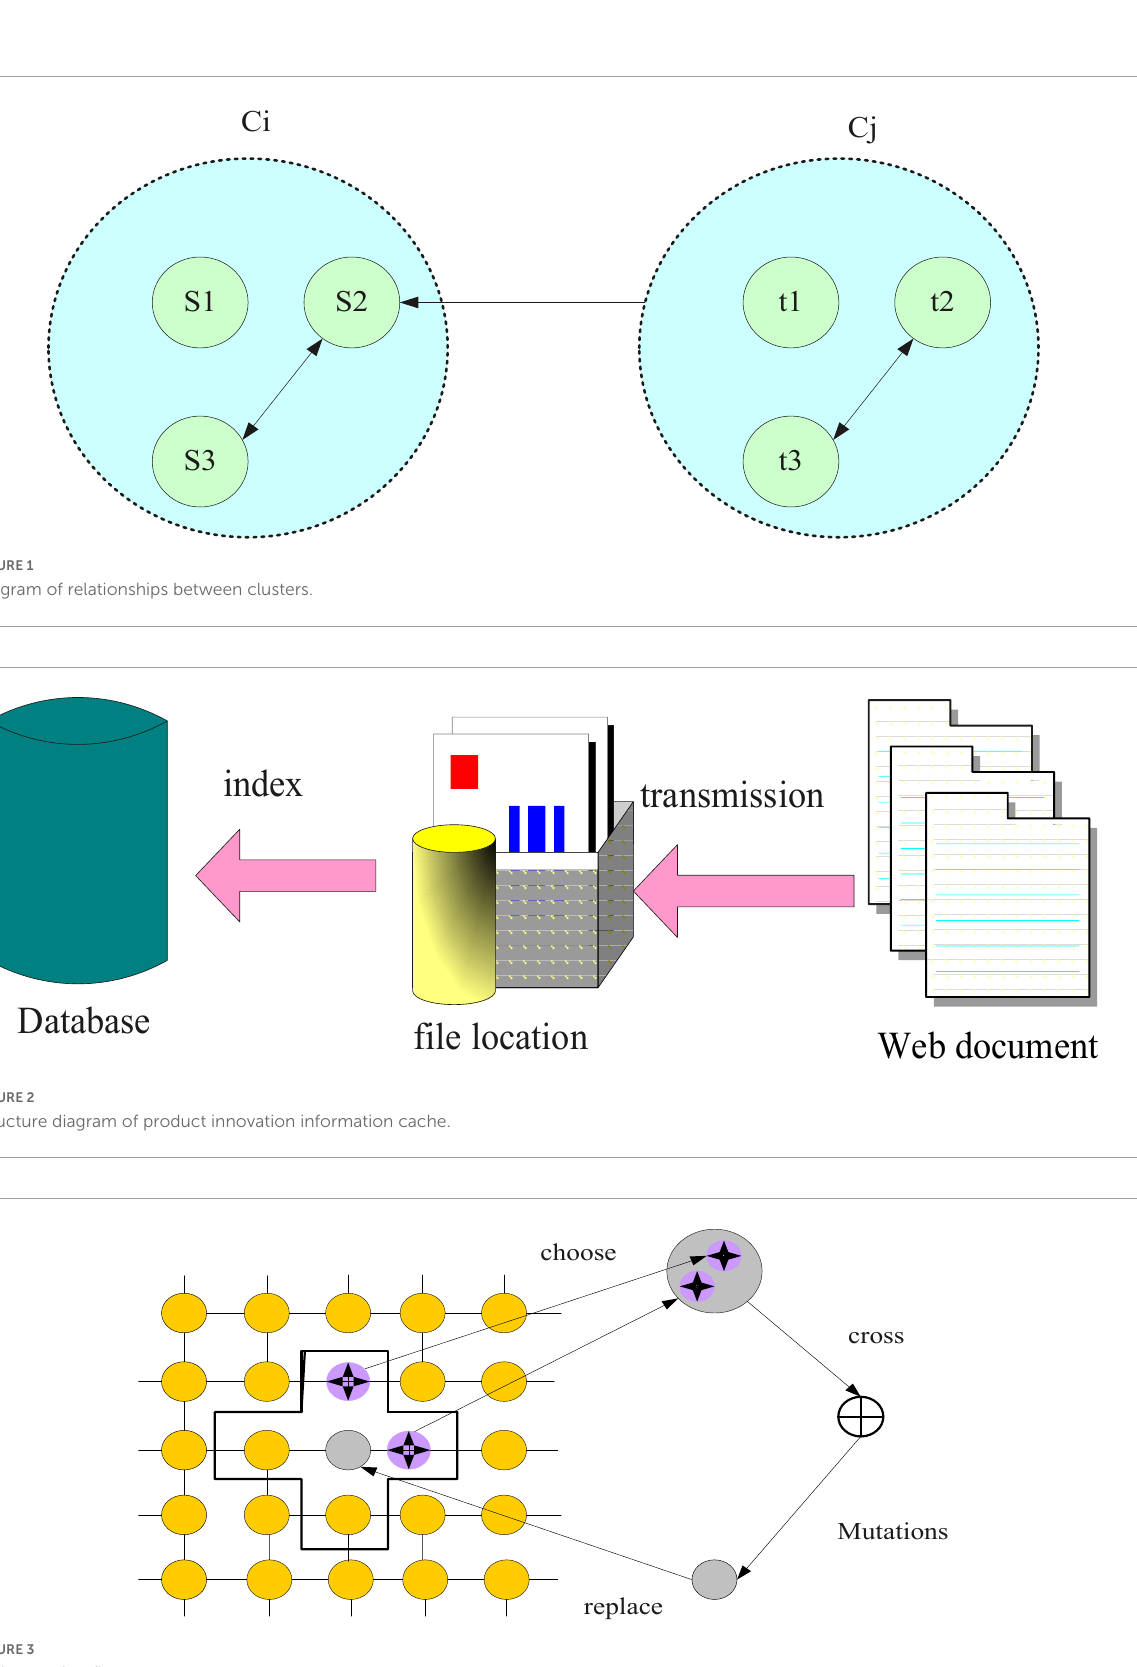
FIGURE3 Cell operation